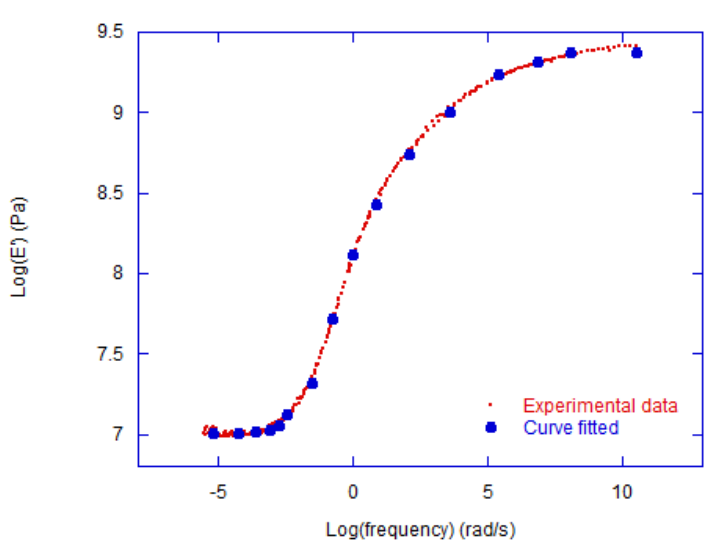
Figure 15. Master storage modulus of Polymer